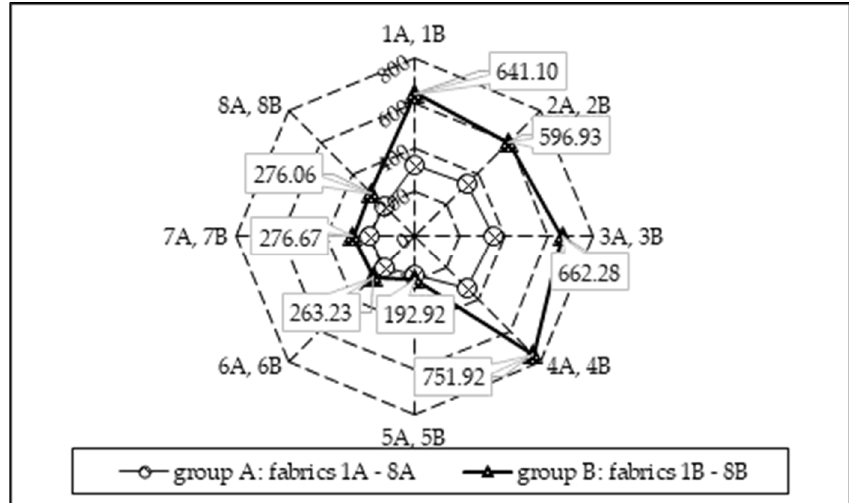
Figure 8. Accumulative one-way transport capability (AOTI) of the fabrics tested.